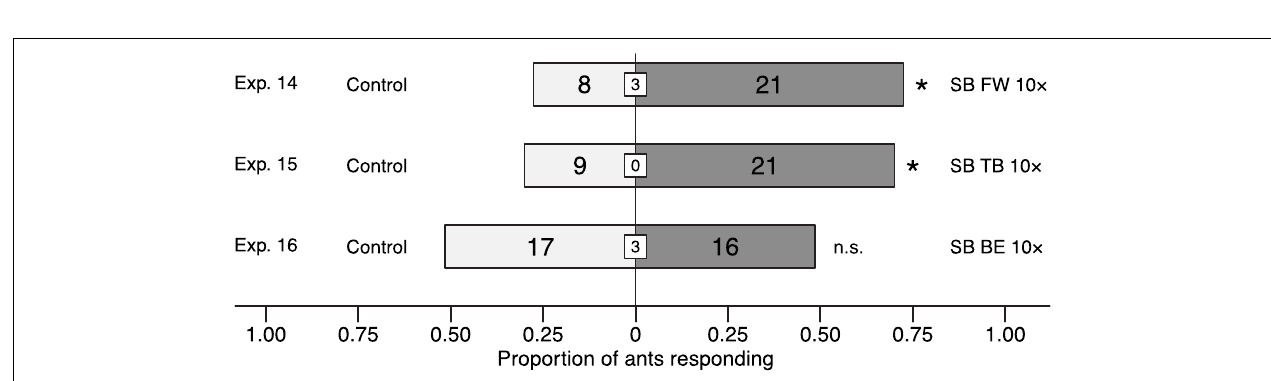
FIGURE 5 | Effect of headspace volatile extracts (HVEs) of fireweed, thimbleberry, and bird excreta on responses of Camponotus modoc worker ants in Y-tube olfactometer ( Figure 1 ) experiments 9–12, each with 28–31 responding ants. HVEs in pentane/ether (1/1) were tested at doses equivalent (1 × ) to volatiles released from natural sources (Exps. 3, 4, 8) or 10-fold higher (10 × ). The same volume of pentane/ether (1/1) served as control stimulus. Numbers within bars indicate the number of ants responding to test stimuli and numbers within white inset boxes indicate the number of non-responding ants. Asterisks denote a significant preference for a test stimulus (Pearson’s χ 2 tests: p < 0.05; n. s., not significant).